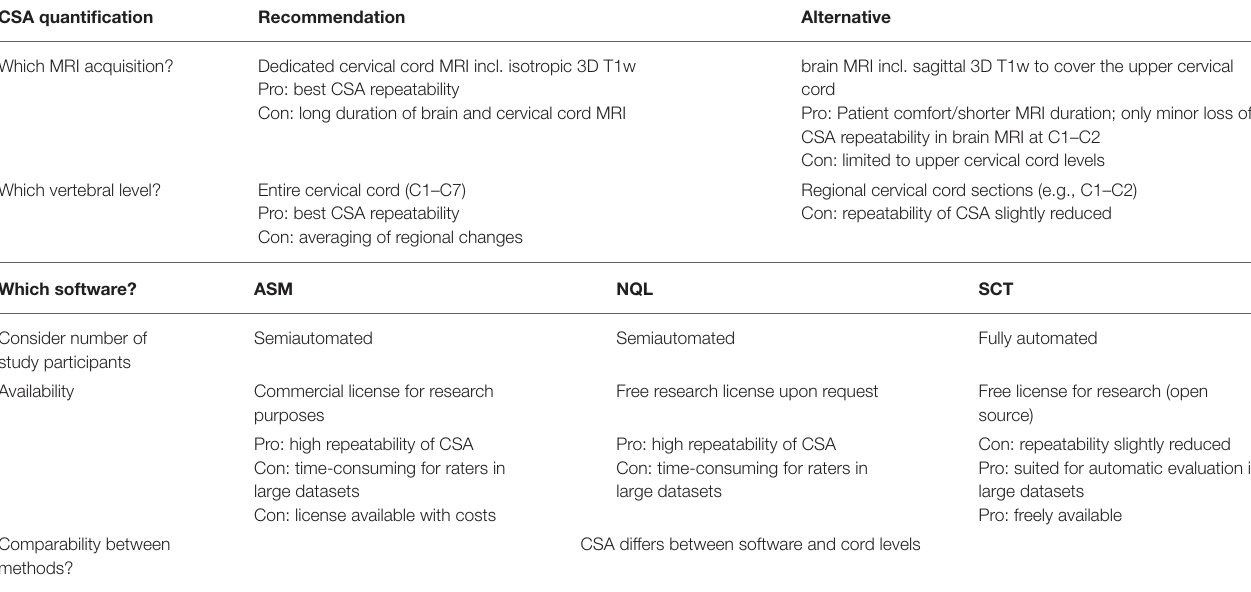
TABLE 5 | Recommendations for cervical cord section and software method in CSA